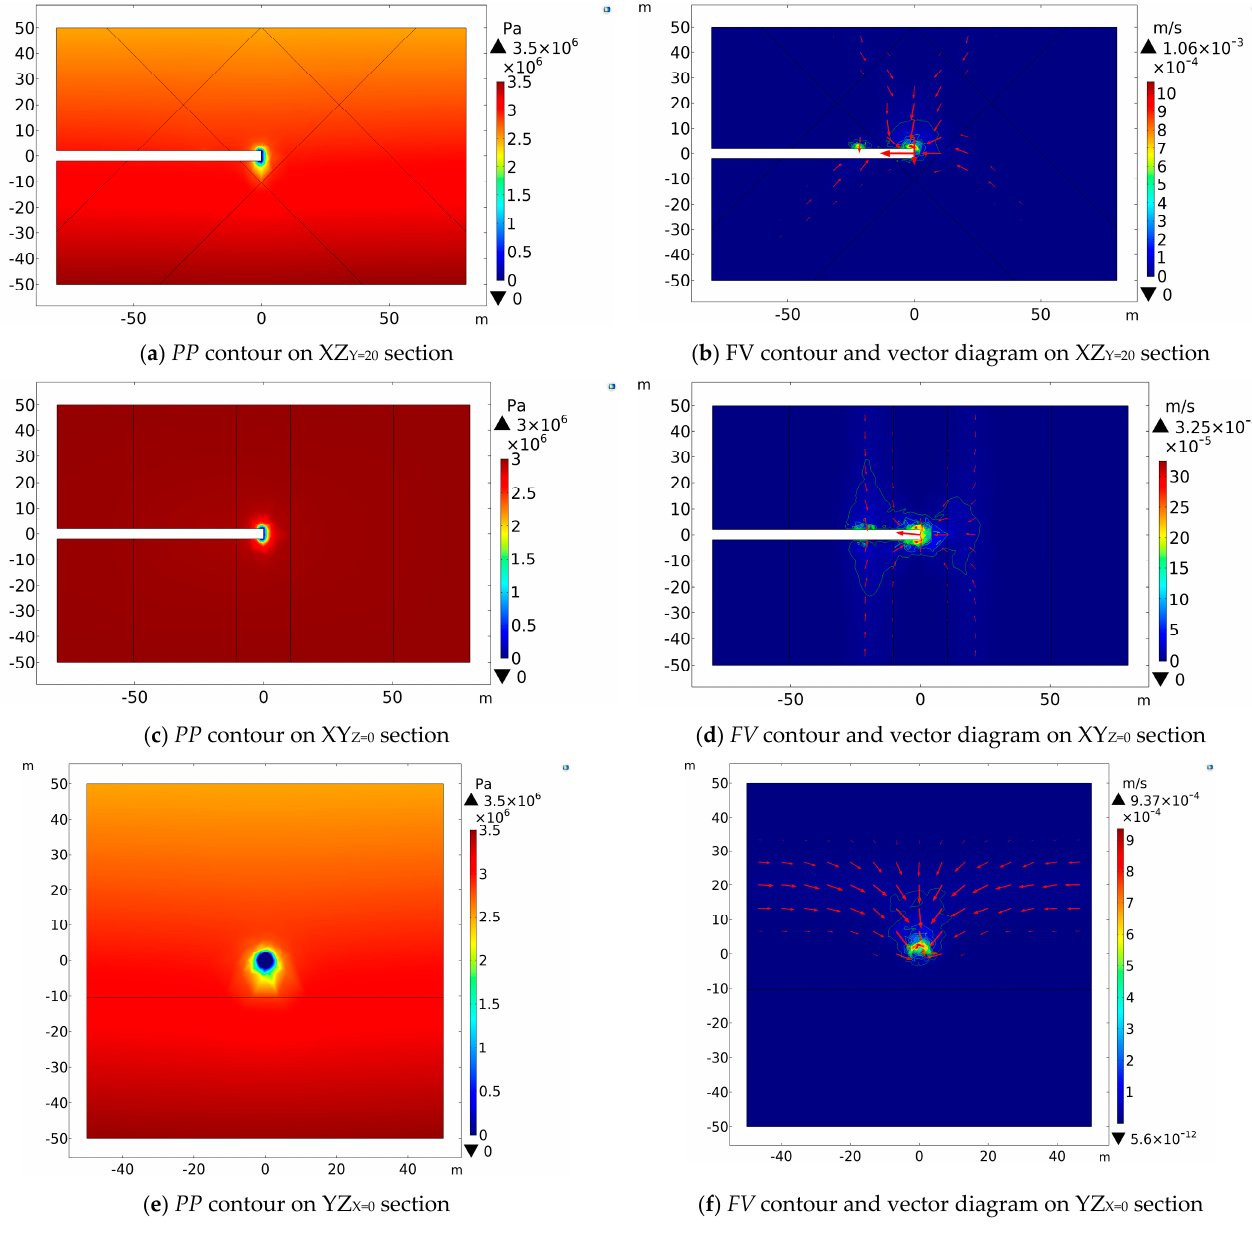
Figure 4. Simulation results for the case Y = 20 m.